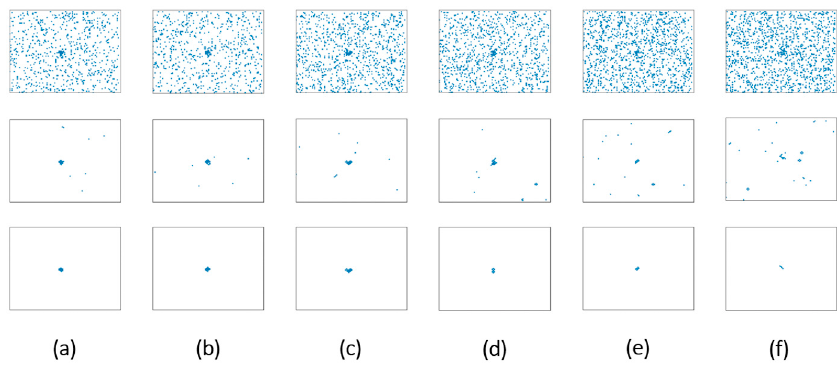
Figure 10. Processing diagrams under different SNRs: ( a – f ) Gradual decrease in